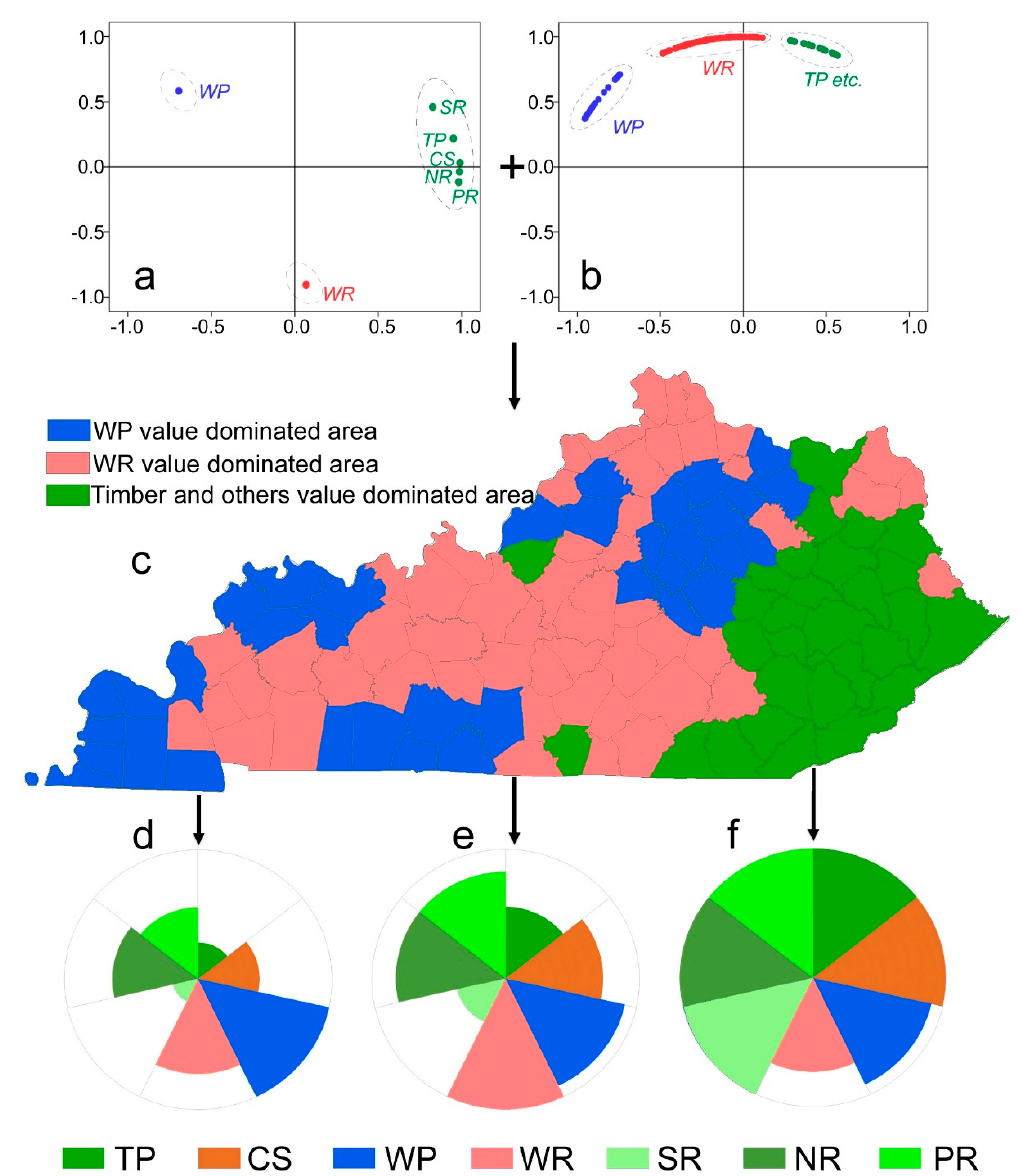
Figure 4. Ecosystem services bundles and spatial cluster. TP is an abbreviation for timber production; CS is for carbon sequestration; WP is for water production; WR is for water retention; SR is for soil retention; NR is for nitrogen retention and PR is for phosphorus retention. ( a ) The bundle of each ecosystem service based on PCA analysis; ( b ) the bundle of counties based on PCA analysis; ( c ) the spatial distribution of dominated ecosystem services area; ( d )–( f ) the dominated ecosystem service types.